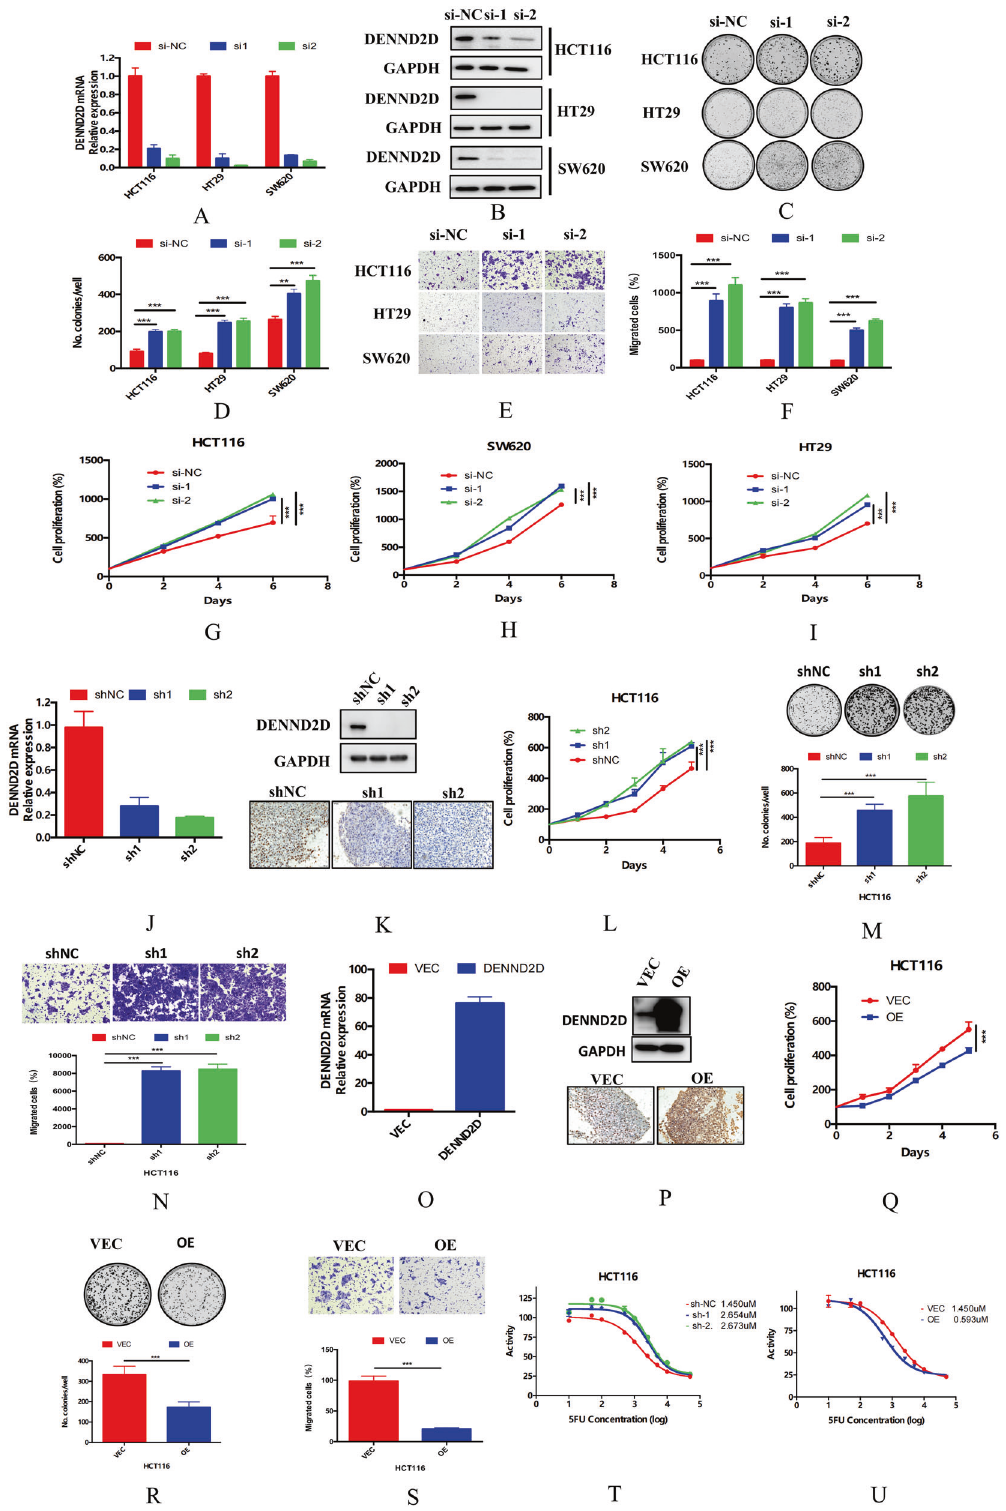
Fig. 3 DENND2D suppressed tumor proliferation, migration and colony formation in vitro. A , B DENND2D was knockdown by siRNA in HCT116, HT29 and SW620 con fi rmed by qPCR and western blot. C , D CRC cell proliferation was promoted by DENND2D knockdown. E , F CRC cell migration was promoted by DENND2D knockdown. G – I CRC cell proliferation was promoted by DENND2D knockdown. J , K DENND2D was knocked down by shRNA in HCT116 con fi rmed by qPCR, western blot, and IHC. L , M CRC cell proliferation was promoted by DENND2D knockdown. N CRC cell migration was promoted by DENND2D knockdown. O , P DENND2D was overexpressed in CRC cells by shRNA con fi rmed by qPCR, western blot, and IHC. Q , R CRC cell proliferation was suppressed by DENND2D overexpression. S CRC cell migration was suppressed by DENND2D overexpression. T , U CRC cells are more sensitive to 5FU after DENND2D knockdown.